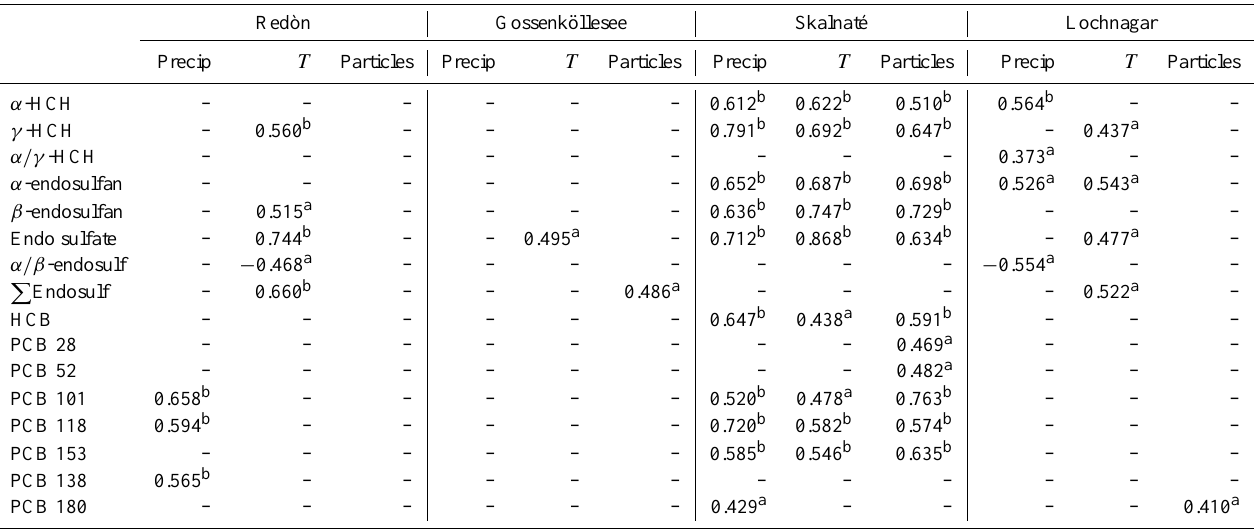
Table 4. Pearson correlation coefficients of OC deposition fluxes (ngm − 2 mo − 1 , log-transformed) and monthly mean temperature ( T , ◦ C), precipitation (Precip, mmmo − 1 ), and particle deposition (mgm − 2 mo − 1 , log-transformed) for the study